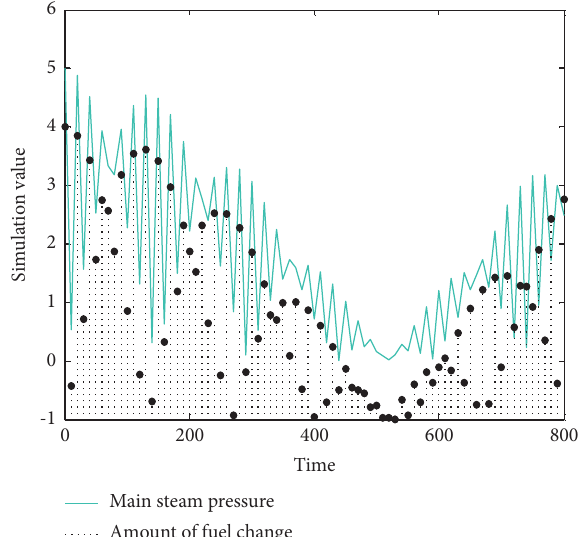
Figure 9: Parameter tuning and simulation results of the main steam pressure controller of the combustion control